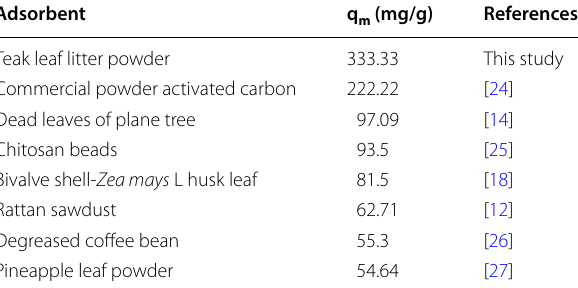
Table 2 Comparison of the reported maximum monolayer adsorption capacities of selected adsorbents for MG Adsorbent q m (mg/g)